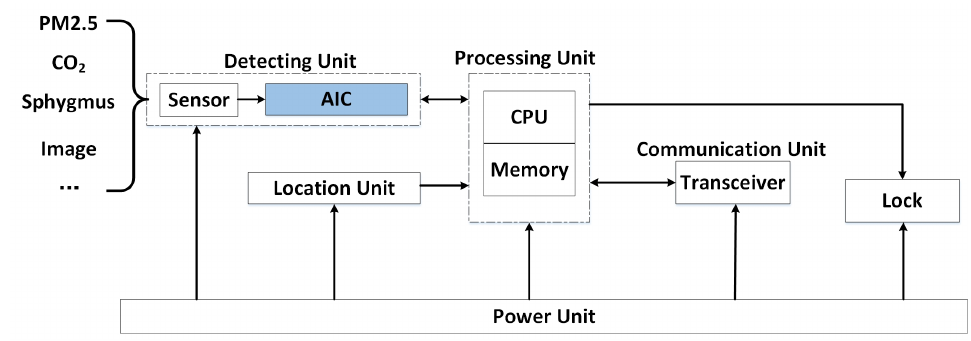
Figure 9. An AIC-based system structure of the sensing node in IoSB.